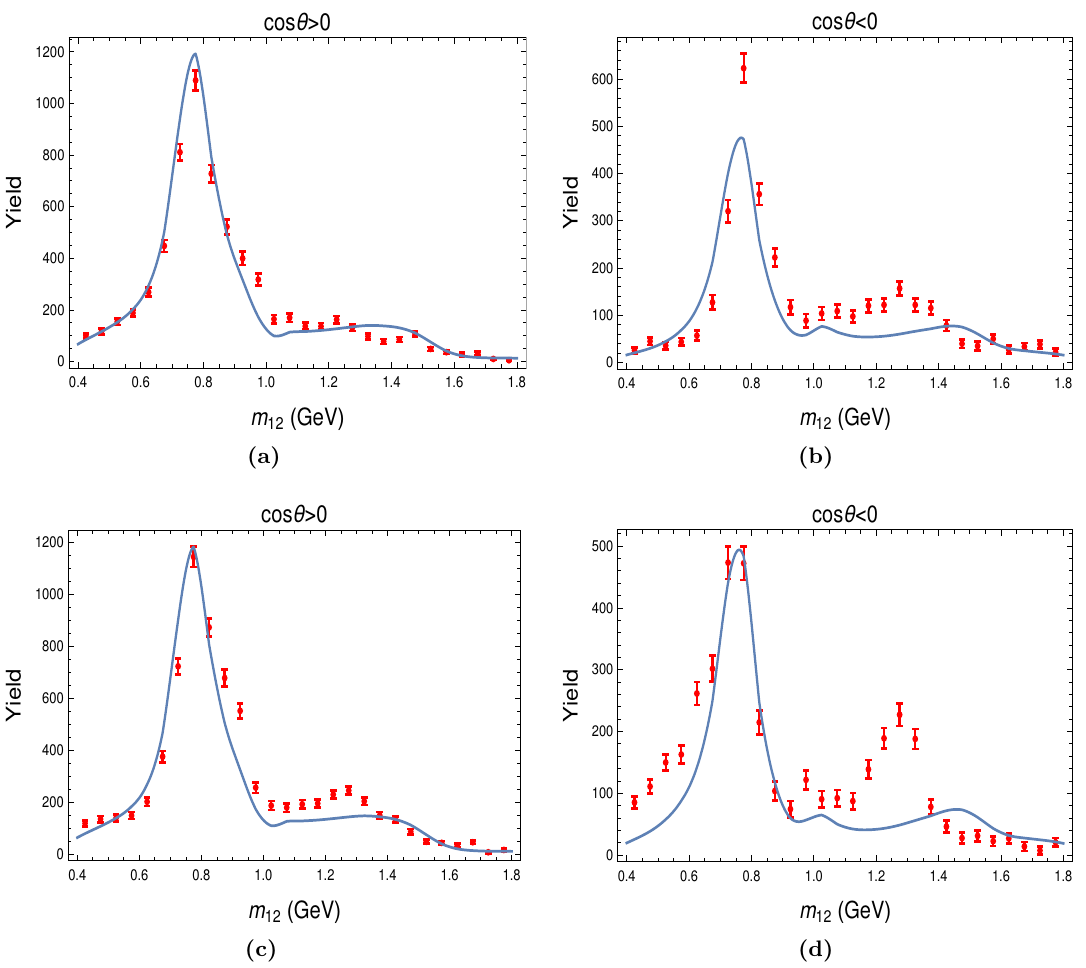
Figure 4. Best (cid:12)t of our model for (a, b) B + and (c, d) B (cid:0) and the LHCb projections [7] as a function of m 12